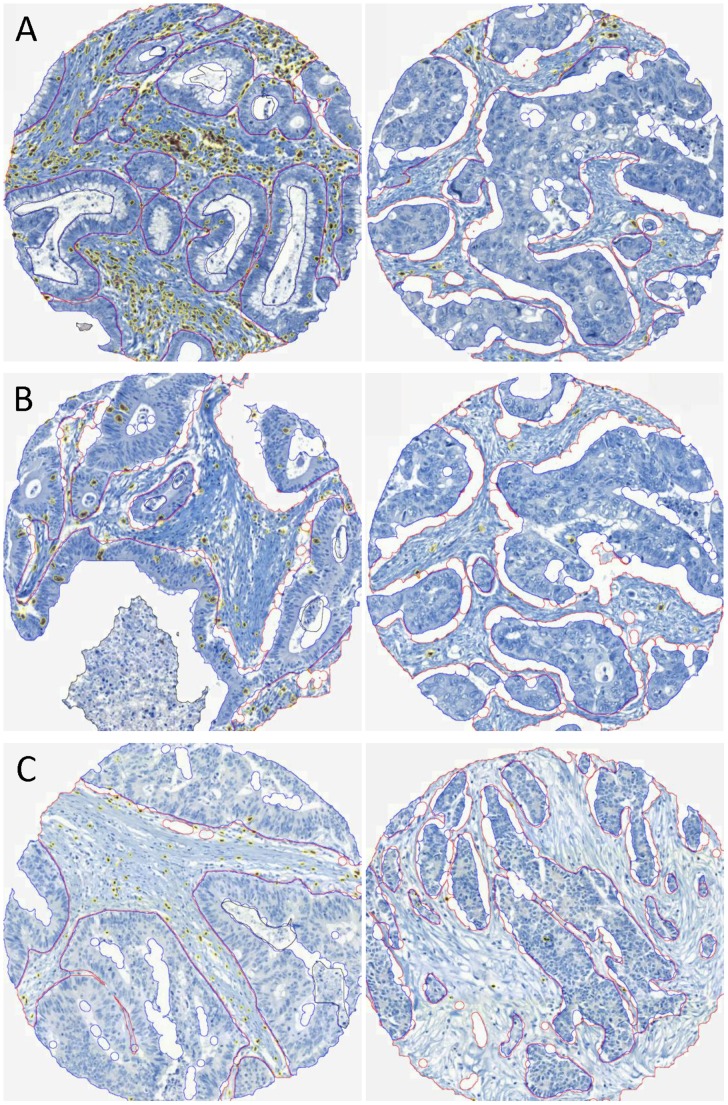
Determination of tumor-infiltrating lymphocyte density.Examples of tumor center chips with CD3 (A), CD8 (B) and FoxP3 (C) staining. Left panels are examples of high TIL densities and right panels are examples of low TIL densities. The stroma is circled in red, the epithelium in blue, and black areas are excluded. The marked areas that are taken into account to calculate the lymphocyte infiltrate density are circled in yellow. All data were acquired with Chip’s N Cheap TMA analysis program.